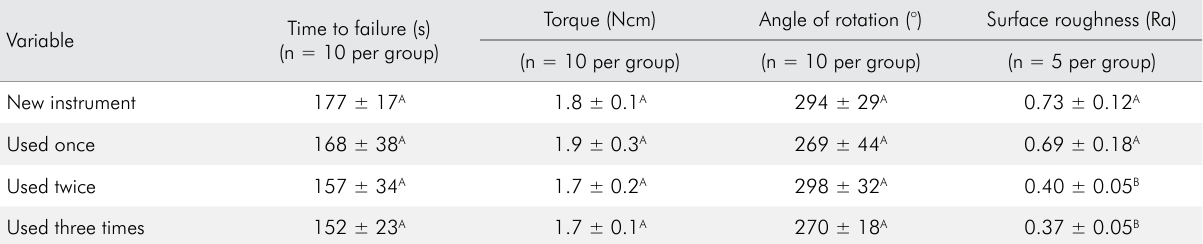
Table. Mean and standard deviation of time to failure (s), torque (Ncm), angle of rotation (°) and surface roughness (Ra) of Reciproc instruments unused and with different number of times of clinical use.